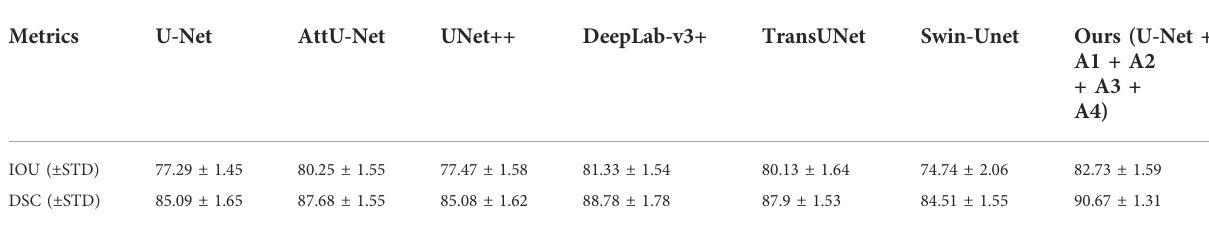
TABLE 4 Metrics for each model